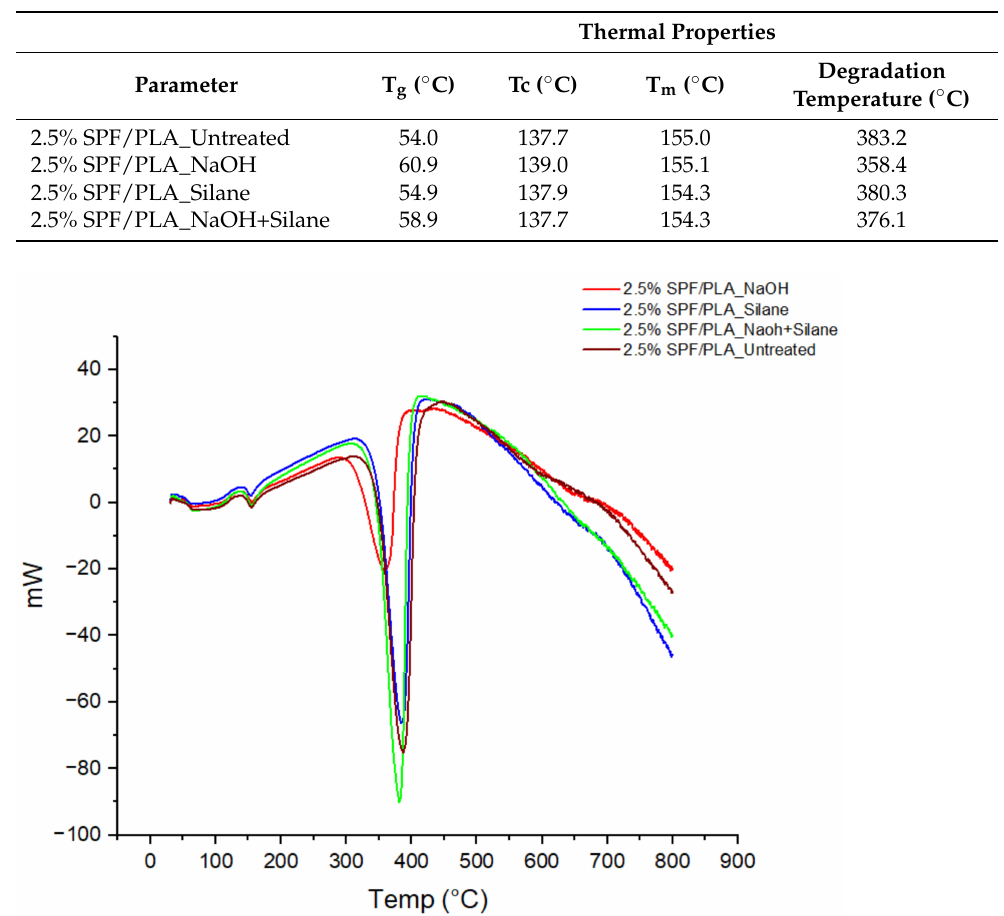
Table 4. Results obtained from the DSC test.